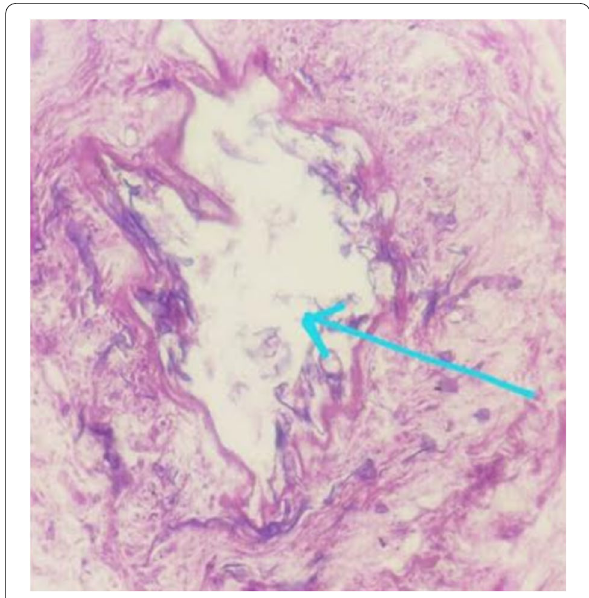
Fig. 4 HPE image showing broad, aseptate and obtuse angle branched fungal hyphae with angioinvasion -suggestive of